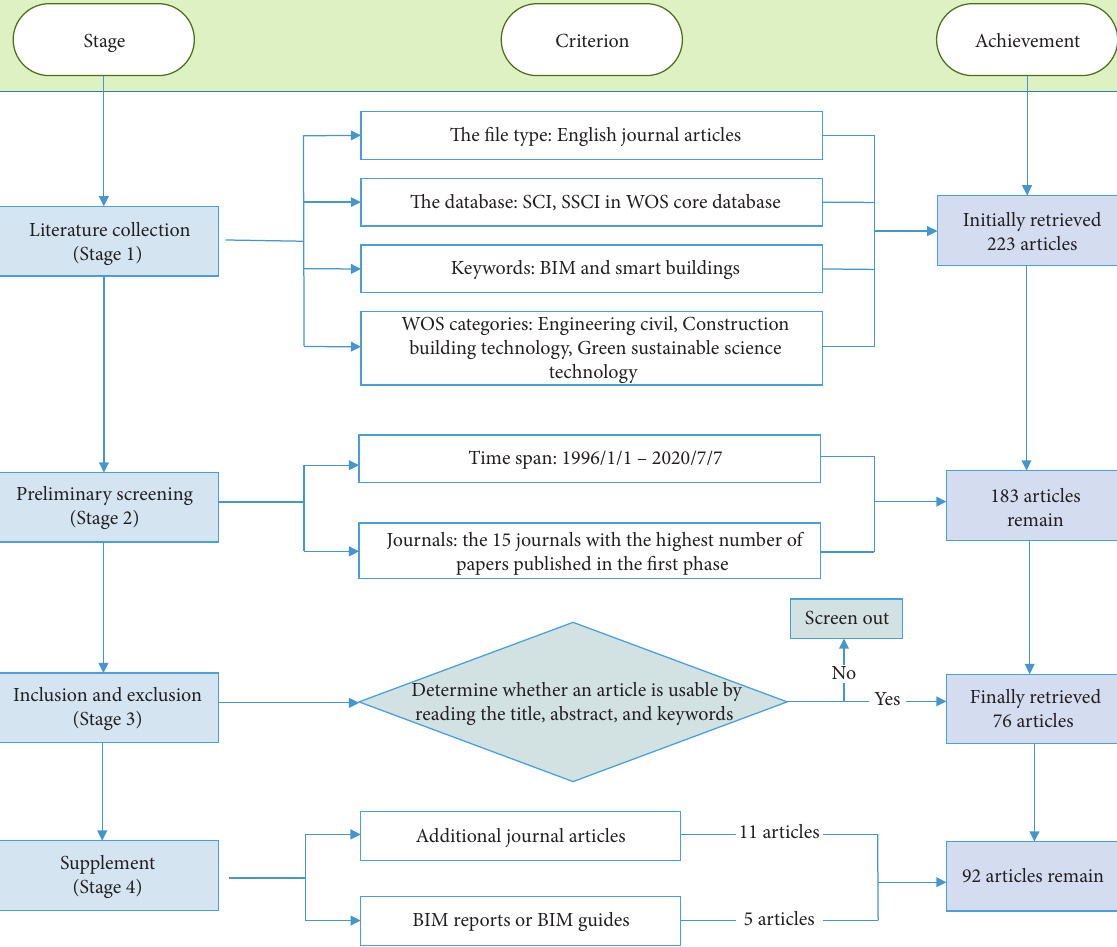
Figure 1: Literature research retrieval and selection